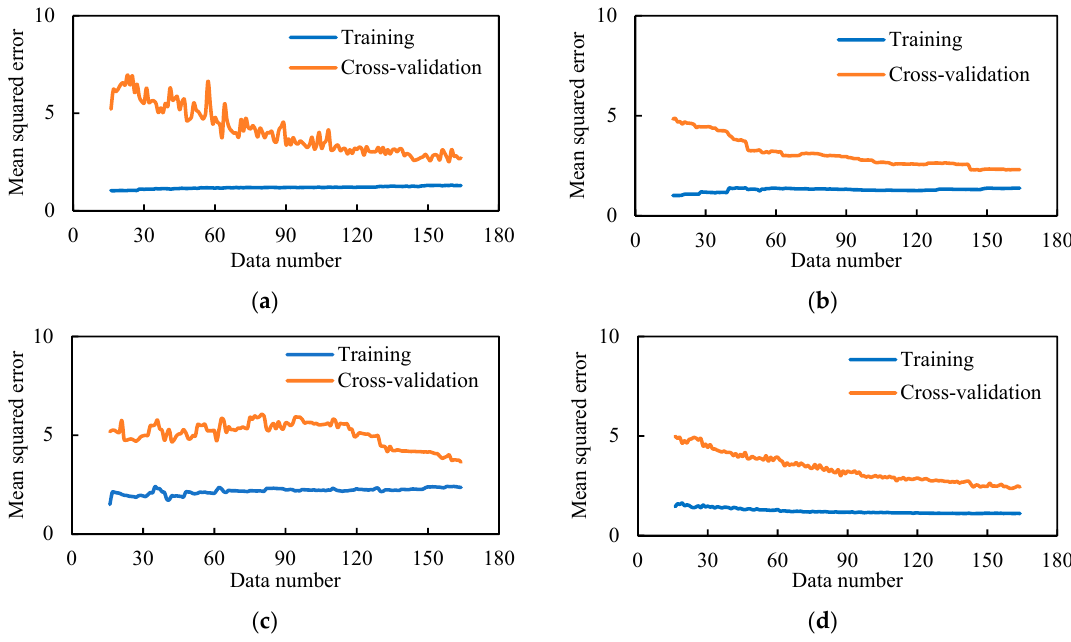
Figure 7. Learning curve for the training process (tensile strength) using: ( a ) ANN, ( b ) SVR, ( c ) CART, and ( d )